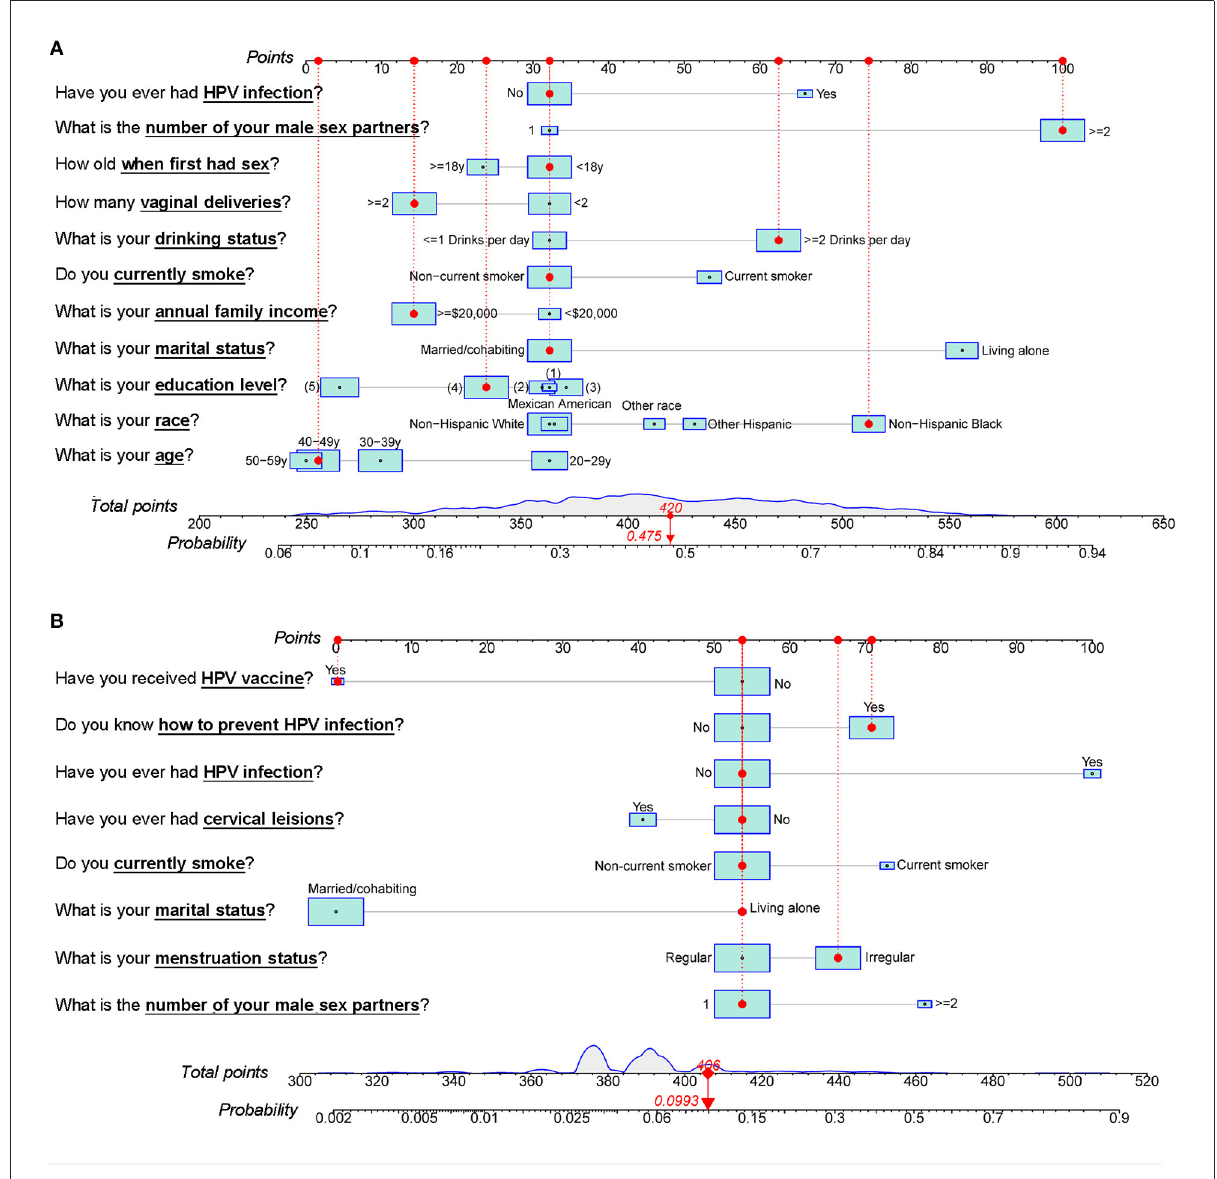
FIGURE5 Modelbest-based nomograms for the (A) NHANES cohort and (B) Beijing female cohort. The red dots, dotted lines, upper and lower red numbers, respectively represent the characteristics, the corresponding points, total points and the likelihood to be infected by HPV for an individual. (1), < 9th Grade. (2), 9–11th Grade (Including 12th grade with no diploma). (3), High School Grad/GED or Equivalent. (4), Some College or an AA degree. (5), College Graduate or above level of